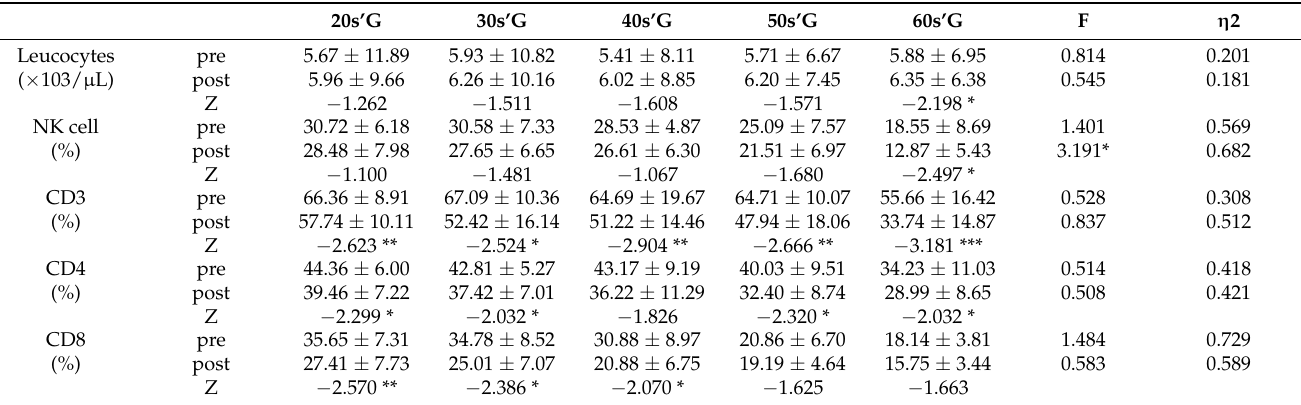
Table 4. Differences and changes in immunocytes among 5 groups.